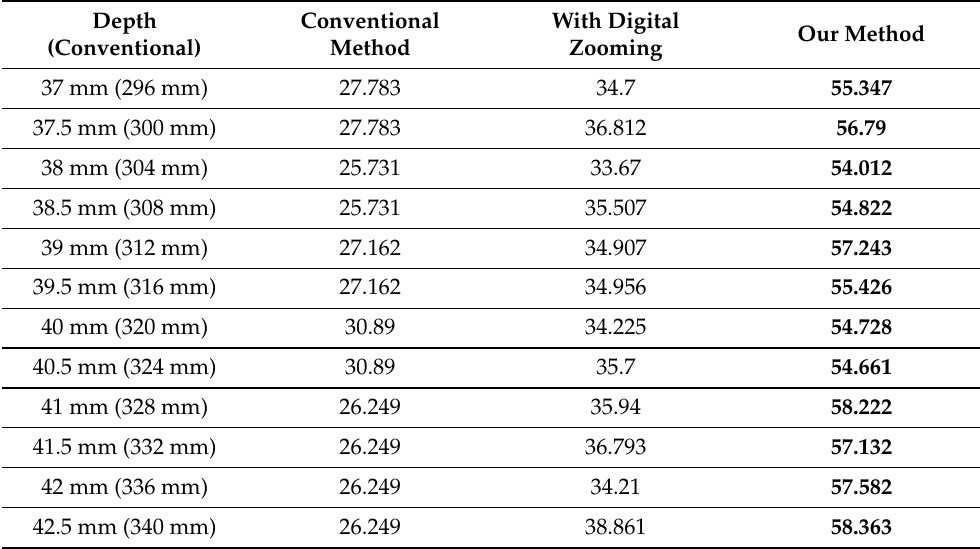
Figure 13. PSR results by computational photon counting integral imaging without digital zoom- ing (conventional method, red line), computational photon counting integral imaging with digital zooming (blue line) and N observation photon counting integral imaging with digital zooming (magenta line). Table 4. Comparison among conventional imaging method, digital zooming method, and our proposed method via various reconstruction depths by